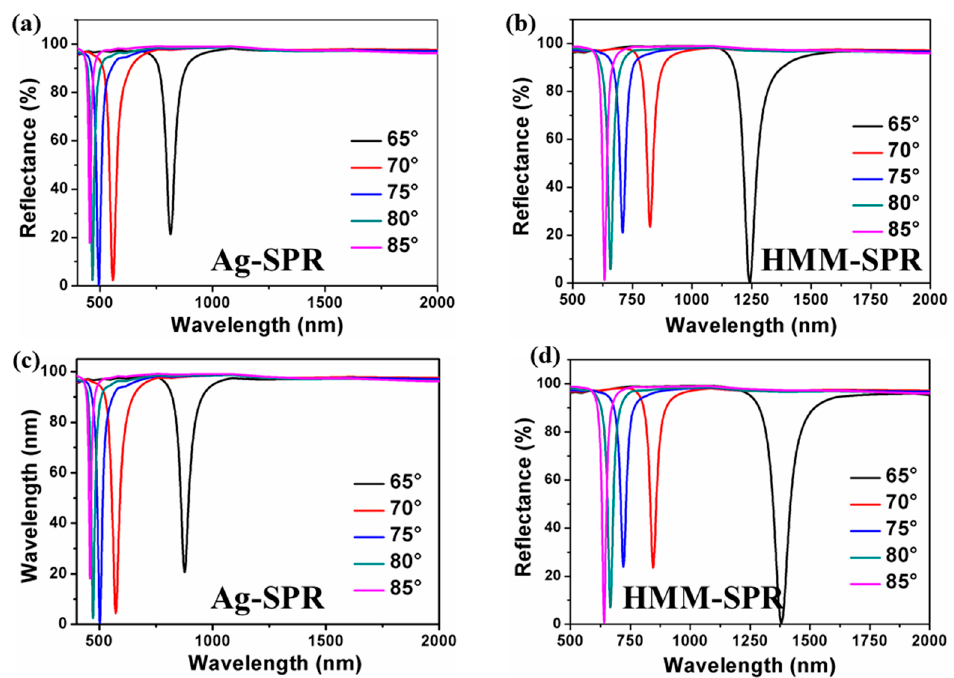
Figure 3. The dependence of reflectance for Ag-SPR and HMM-SPR for SRI = 1.330 ( a , b ), 1.335 ( c , d ) with different incident angles.